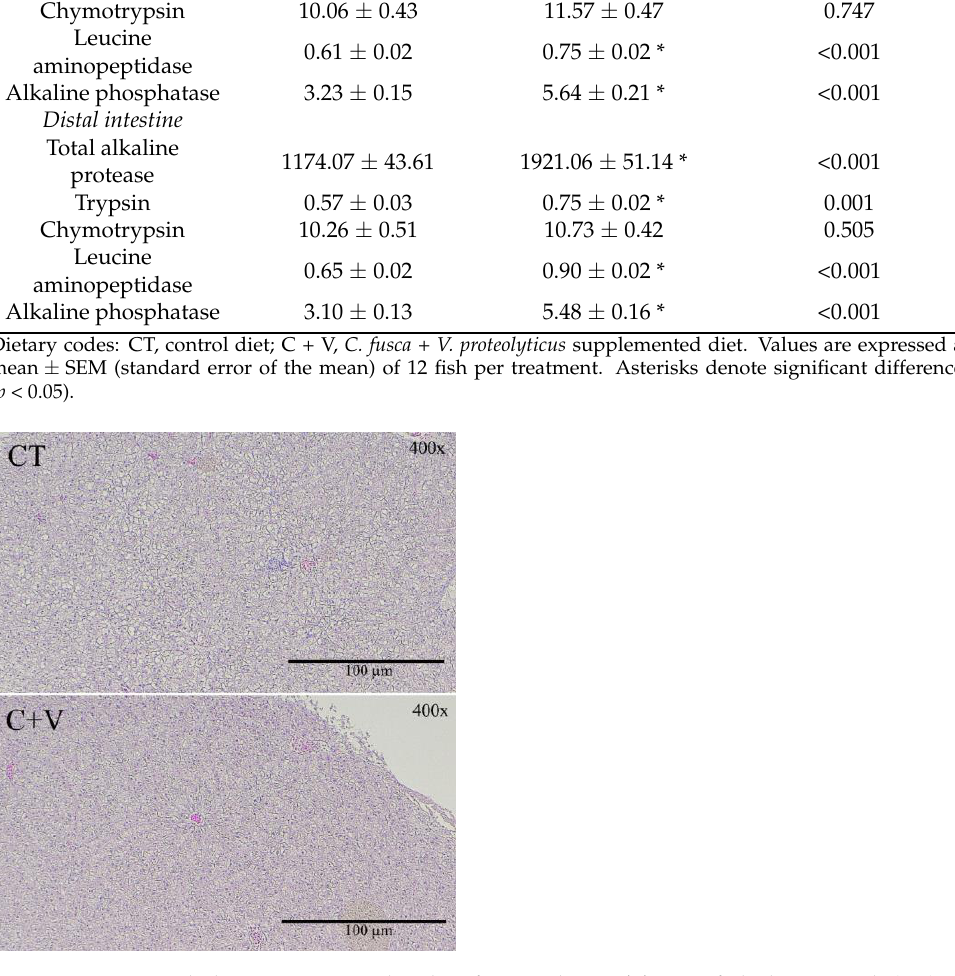
Dietary codes: CT, control diet; C + V, C. fusca + V. proteolyticus supplemented diet. Values are ex- pressed as mean ± SEM (standard error of the mean) of 12 fish per treatment. Asterisks denote sig- nificant differences ( p < 0.05).